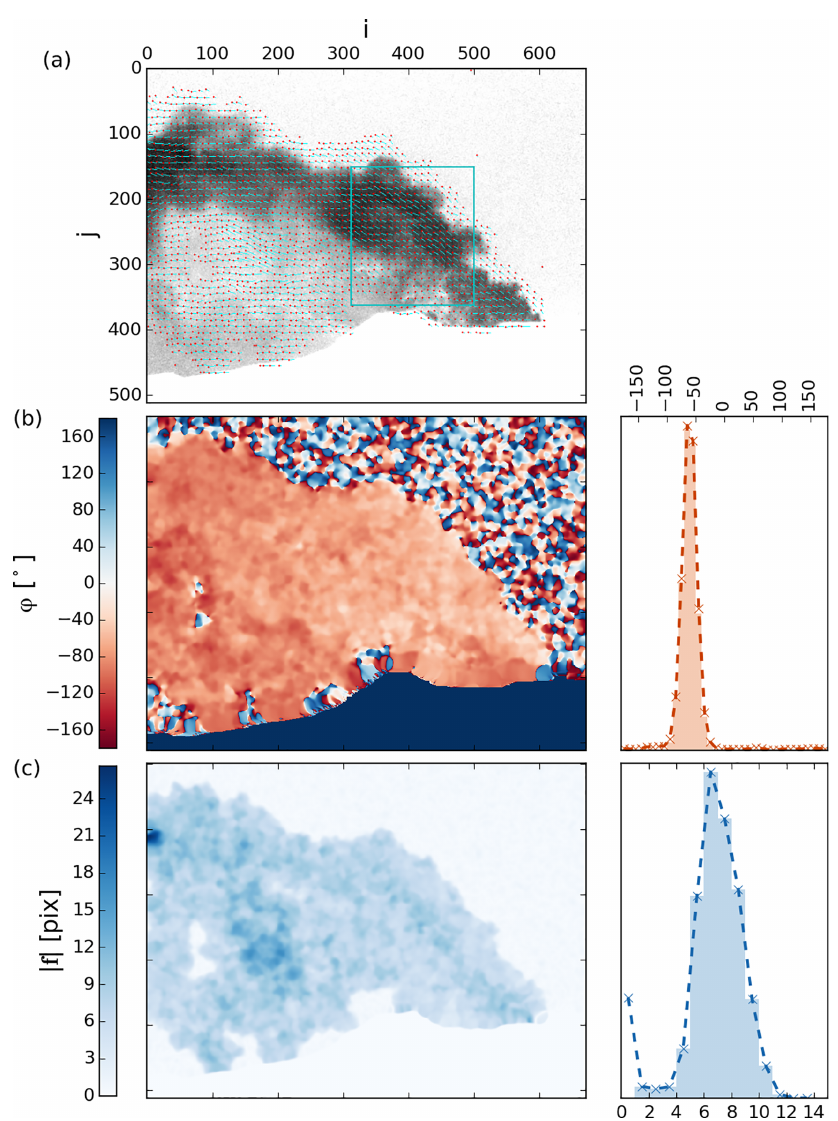
Figure 3. (a) Example output of the Farnebäck optical flow algorithm including a rectangular ROI. Two further images show the correspond- ing orientation angles ϕ (b) and magnitudes | f | (c) of the DVF. Corresponding histograms M ϕ and M | f | are plotted on the right and include all pixels in the displayed ROI. The histograms are plotted both including (dashed lines) and excluding (red and blue shaded areas) short flow vectors (i.e. | f | > | f | min = 1 . 5pix. The orientation angles are plotted in an interval − 180 ◦ ≤ ϕ ≤ + 180 ◦ where − 90 ◦ , + 90 ◦ correspond to − i, + i directions and 0 ◦ to the vertical upwards direction ( − j ). The DVF was calculated using two consecutive AA images ( (cid:49)t = 4 . 0 s ) of the Etna plume, recorded on 16 September 2015 at